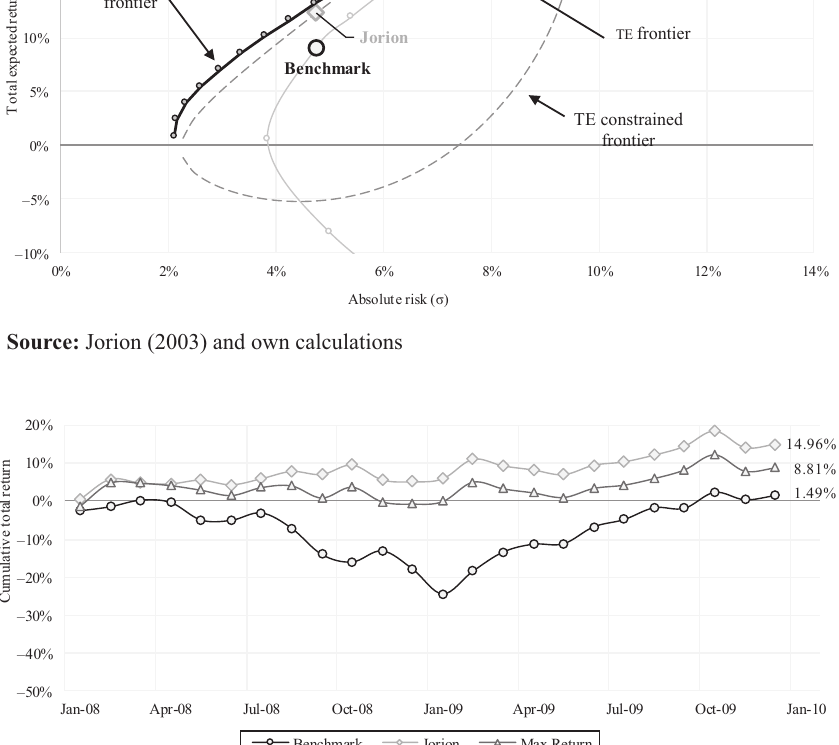
Figure 8. Cumulative return, Test 2, high volatility (40% equities